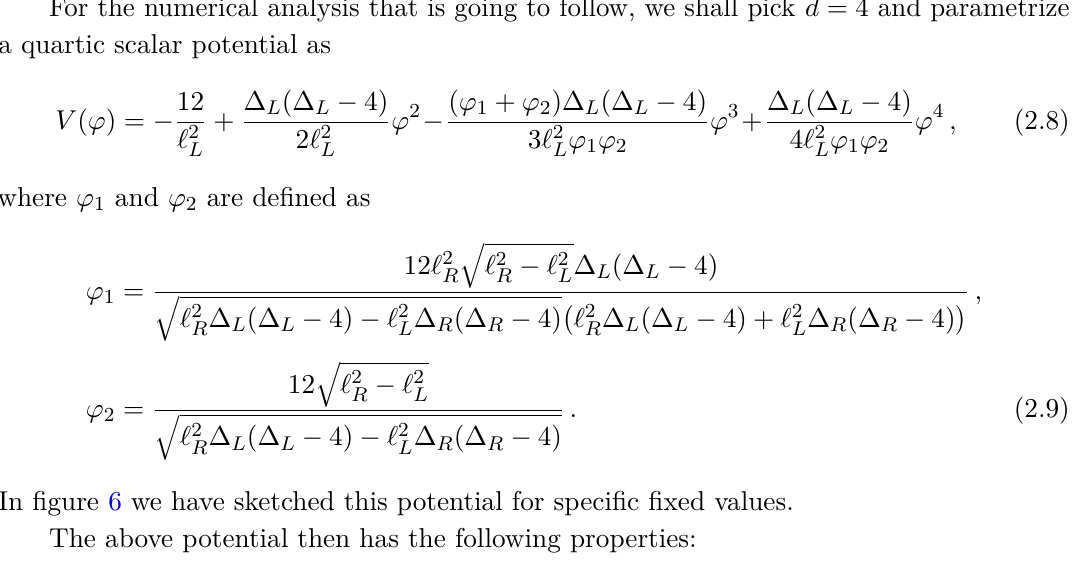
= 4 . 31 . There are two maxima at ϕ = 0 and ϕ 1